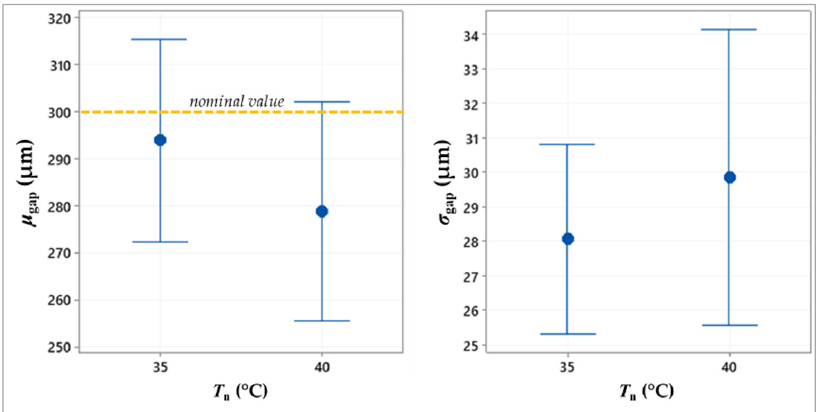
Figure 8. Interval plot of the mean value and standard deviation of the gap against the nozzle temperature.